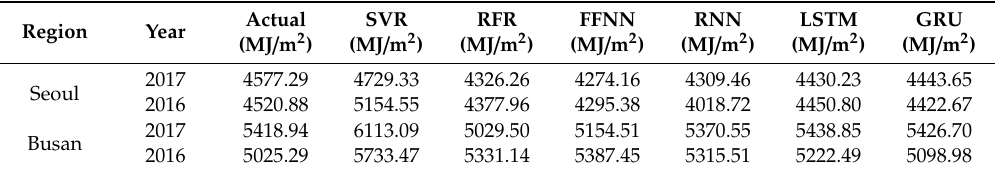
Table 6. Total yearly radiation.